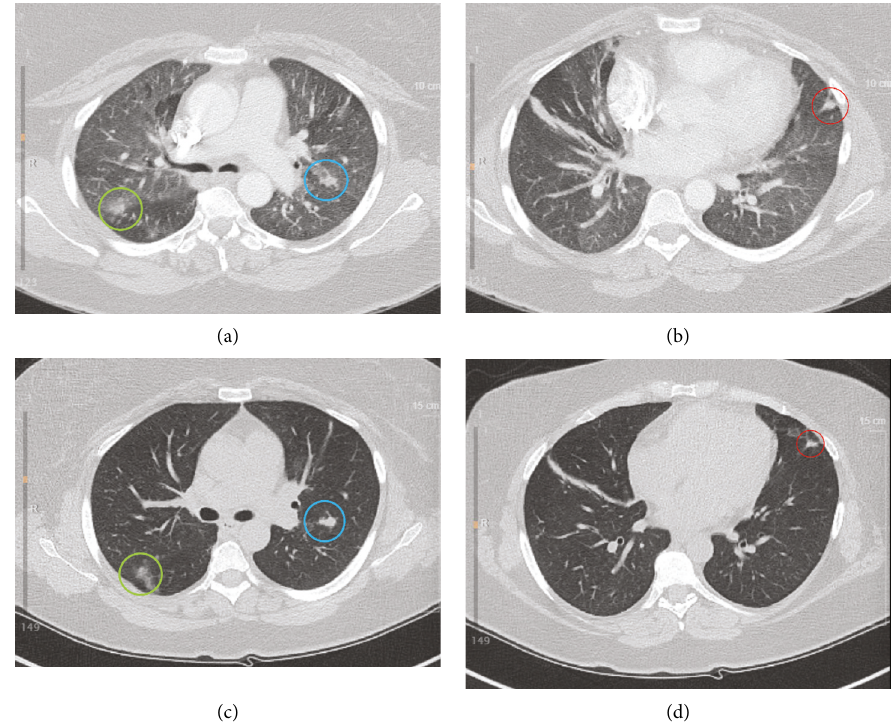
Figure 1: CT chest images from the initial and subsequent hospital presentations. (a) and (b) show CT scan without contrast performed during the patient’s initial presentations demonstrating pulmonary nodules in the left and right upper lobes with blue and green circles, respectively, and a left pulmonary nodule at the base of the left lung with red circle. (c) and (d) show CTscan without contrast performed one month after the patient’s initial consultation demonstrating similar pulmonary nodules to her preliminary visit with nodules identified by the same color circle as in (a) and (b).